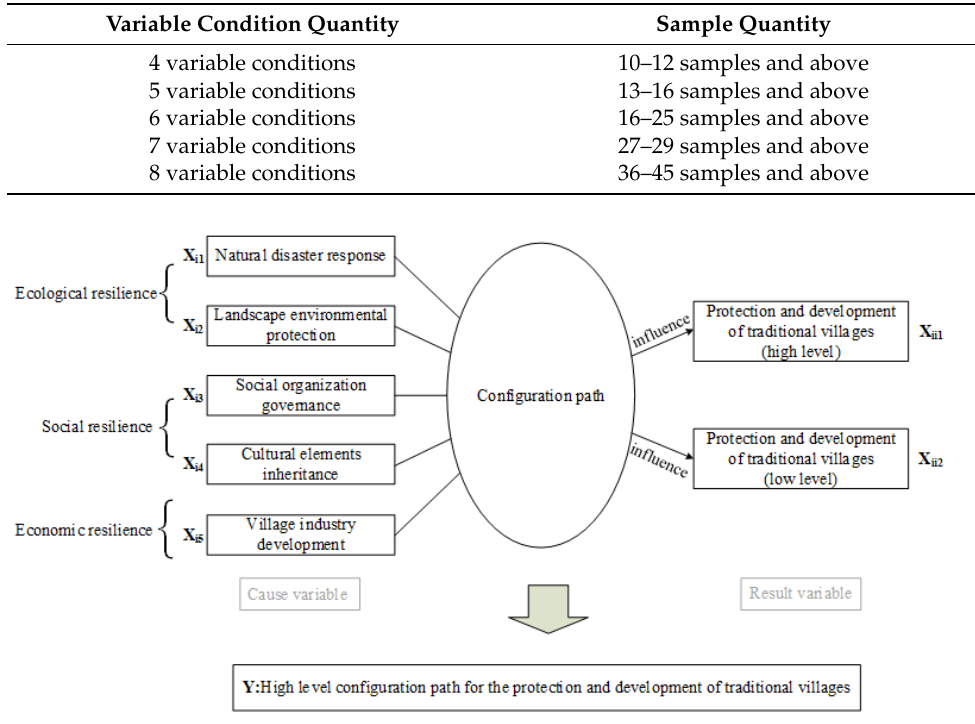
Figure 5. Complex causal model of traditional village protection and development.